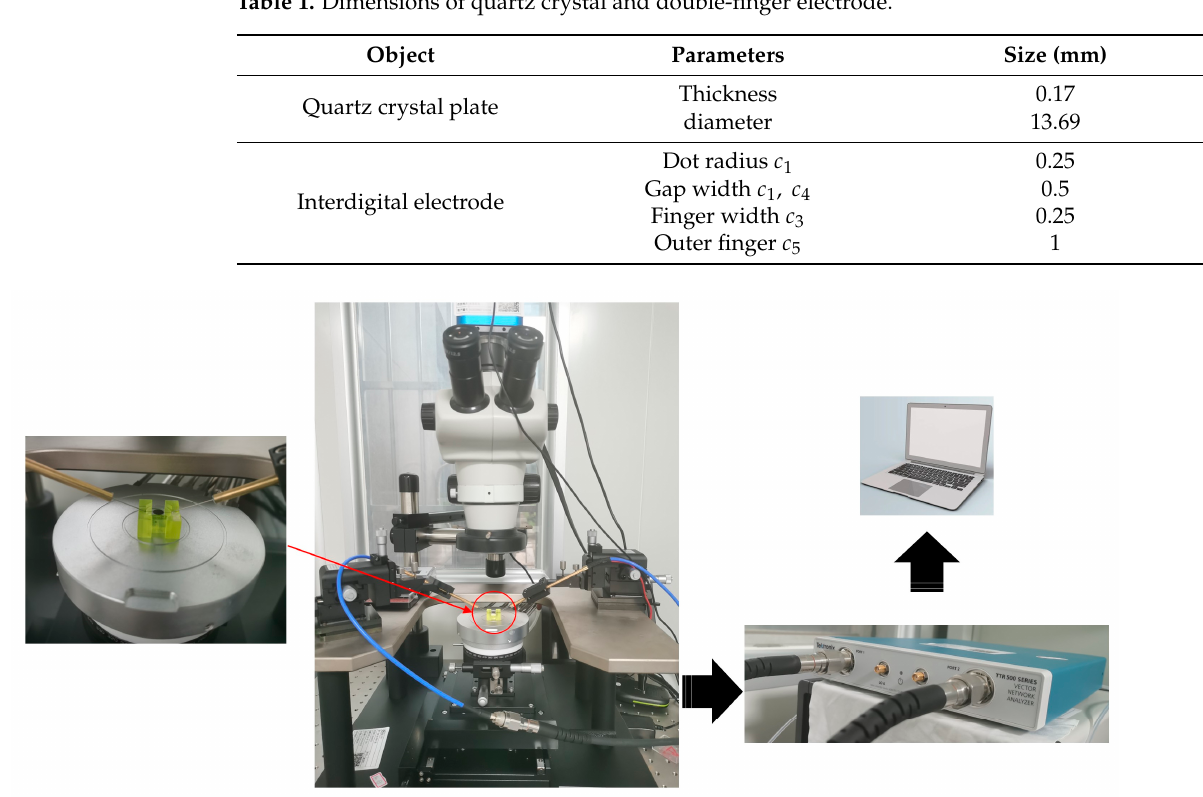
Figure 10. The experiment flow chart of the QCM with interdigital